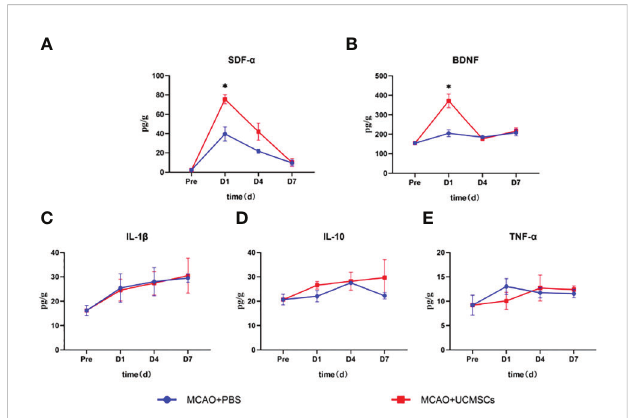
FIGURE 4 Cytokine levels in the brain tissue lysates of MCAO rats after administration of hUCMSCs. (A – E) Expression levels of SDF- a , BDNF, IL-1 b , IL-10, and TNF- a in brain tissue lysates, respectively. Data are presented as mean ± SD. Statistically signi fi cant values between the treatment and the model groups are denoted as *P <